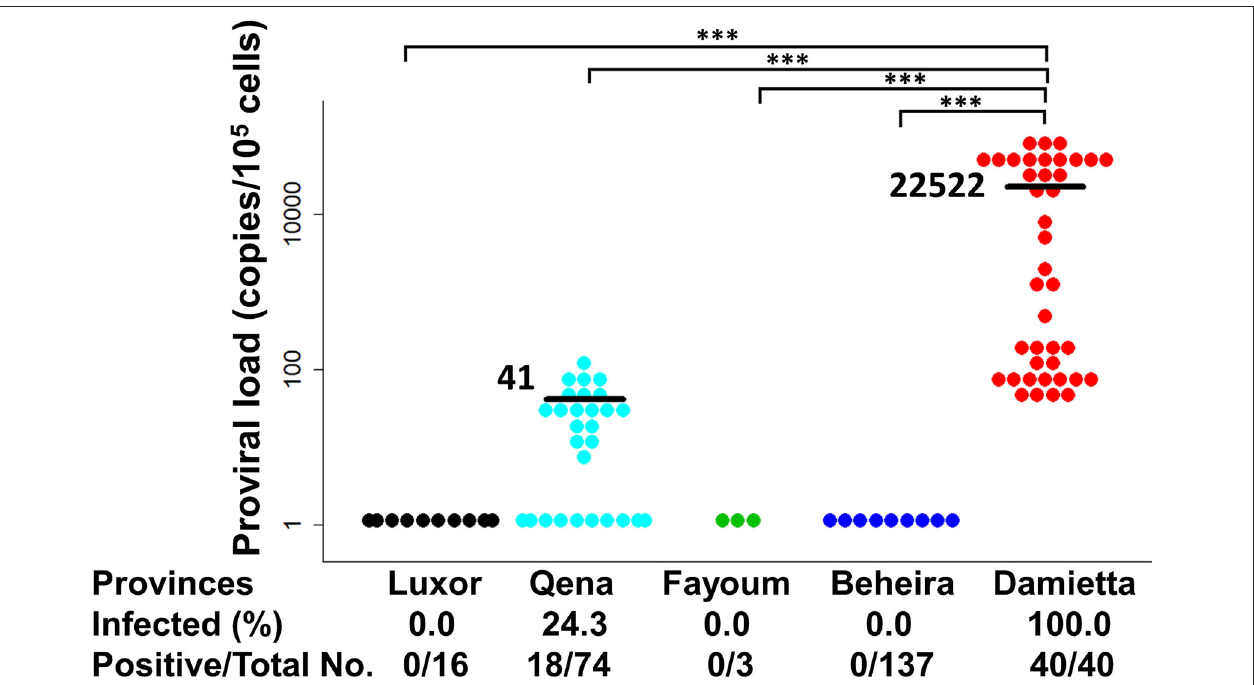
FIGURE 5 | Estimation of BLV proviral load (PVL) among Egyptian cattle. BLV PVL calculated using CoCoMo-qPCR-2 among cattle samples were tested in five different provinces in Egypt. Black bars show the main BLV PVL values. The actual number (No.) of cattle reported positive via BLV-CoCoMo-qPCR-2 per total No. of tested cattle and BLV-infected rate (%) are indicted at the bottom of each block. Significant differences between different geographic regions were calculated using Tukey’s test. P < 0.05 was considered significant. *** P <